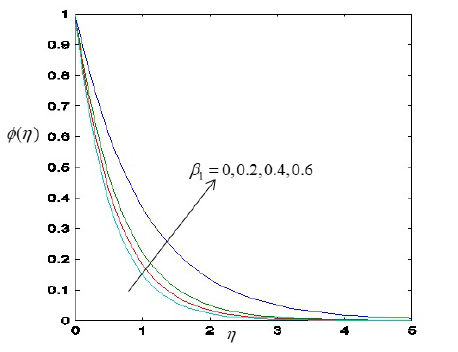
Fig. 11: Influence of Deborah number in terms of relaxation time β 1 on ϕ ( η )